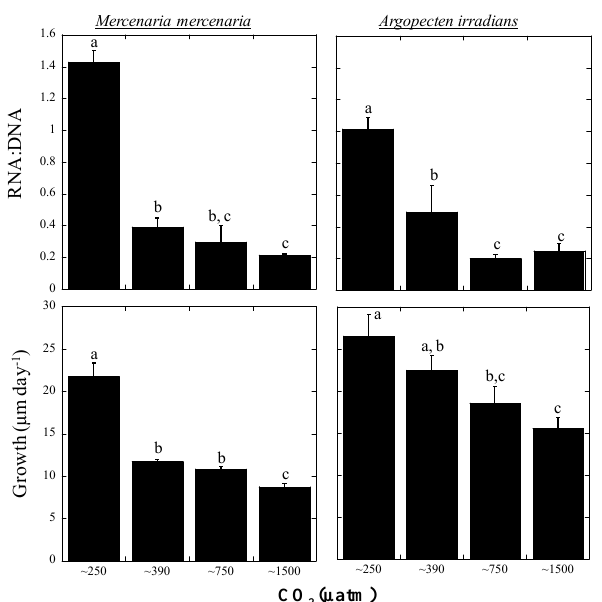
Fig. 4. Survival ± standard deviation of Argopecten irradians lar- vae under varying days of exposure to approximately 750µatm CO 2 Figure 4. Survival ± standard deviation of Argopecten irradians larvae under varying 967 (Table 4). Black and grey bars represent larvae that were switched days of exposure to approximately 750 µatm CO 2 (Table 4). Different colors indicate the 968 from high to low and low to high CO 2 , respectively ( n = 4 per treat- CO 2 exposure the larvae experienced first and then were switched to ( n =4 per treatment). 969 ment). Letters indicate significant differences revealed from Tukey Letters indicate significant differences revealed from Tukey post-hoc multiple 970 comparisons, p ≤ 0.05 for all, and * indicated these individuals only experienced either 971 post hoc multiple comparisons, p ≤ 0 . 05 for all. ∗ indicates these 390 µatm or 750 µatm and were never switched. 972 individuals only experienced either 390µatm or 750µatm and were 973 never